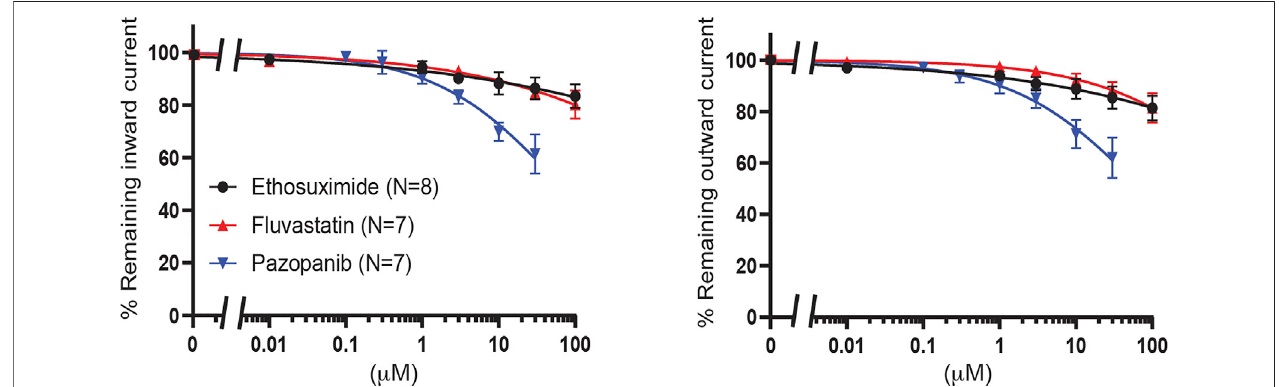
FIGURE 9 | Evaluation of K IR 6.2/SUR2a dependent currents in response to ethosuximide, fl uvastatin and pazopanib. IC 50 curves of WT K IR 6.2/SUR2a inward (at − 80 mV),leftpanel,andoutward(at+50 mV),rightpanel,currentinhibitioninresponsetoincreasingconcentrationsdrugs.Datawere fi ttedwithHillequationtoestimate the IC 50 values. Data are shown as mean ± SEM. N depicts number of measurements on independent inside-out patches.